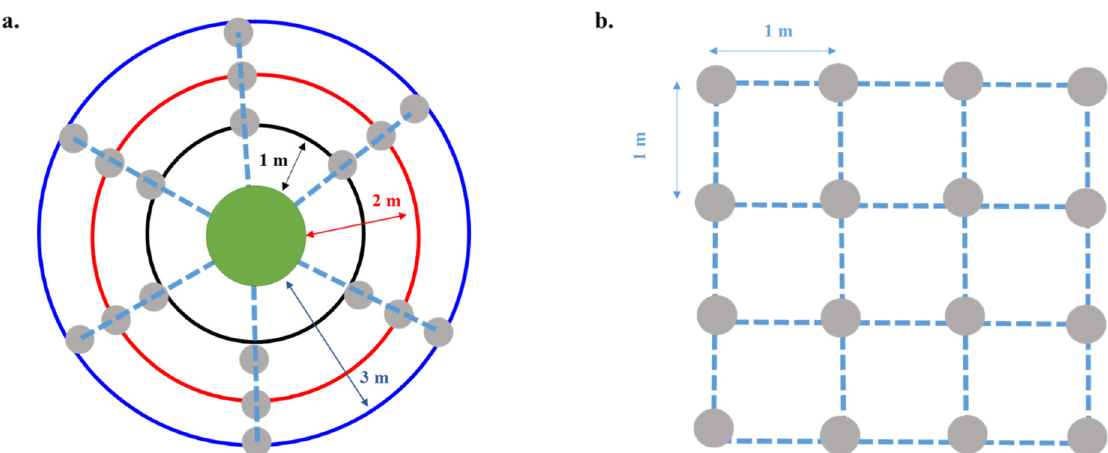
Figure 2. Schemes of the planting plot designs. ( a ) Using present A. spirorbis with the green circle representing the canopy, the target species, represented with grey circles, are planted in a radius around A. spirorbis trees at 3 different distances: the black line represents an area with 6 target species, planted at 1 m from the A. spirorbis canopy limit, the red line is at 2 m, and the blue line is at 3 m. ( b ) On bare soil at least 10 m away from the closest A. spirorbis , the target species, represented with grey circles, are planted in quadra of 4 plants by 4, spaced 1 m from each other.